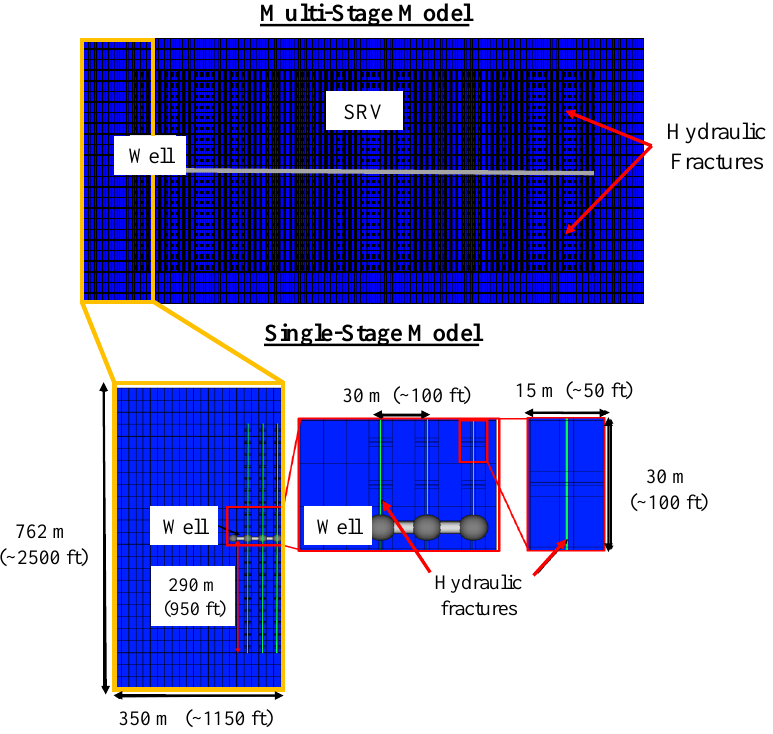
Figure 2. Comparison between the multi-stage model (including 22 stages) and the single- stage model.